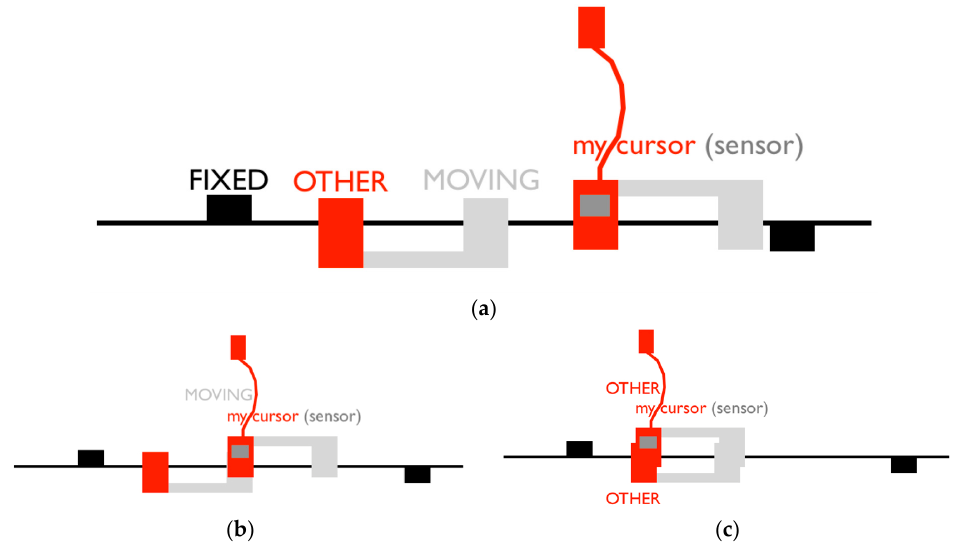
Figure 2. Schematic illustration of the one-dimensional virtual space. ( a ) Participants are embodied as avatars on an invisible line that wraps around after 600 units of space (pixels) in a continuous, circular fashion. Each avatar consists of a sensor (mouse cursor) attached to a body object; ( b ) Unbeknownst to the players, a moving object is connected to each avatar body at a set distance of 50 units. Each participant has her own fixed object located at 150 and 450 pixels, respectively. All objects are 4 pixels wide; (c) A mutual encounter happens when participants are crossing each other, and therefore both simultaneously receive the tactile feedback.